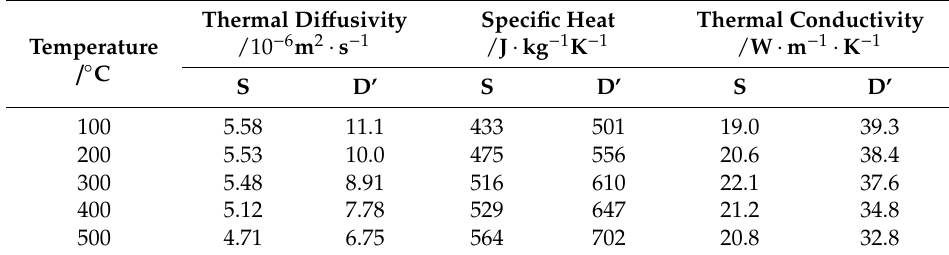
Table 3. Thermal di ff usivity, specific heat, and thermal conductivity of the ductile iron and carbon steel